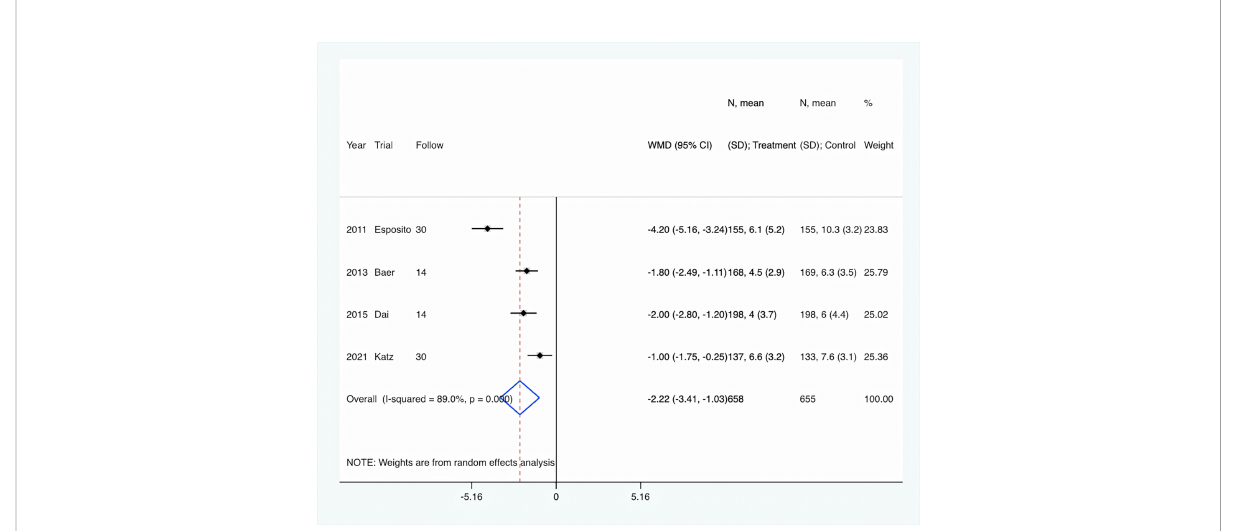
FIGURE 3 PCT-guided treatment was associated with shorter length of antibiotic therapy.